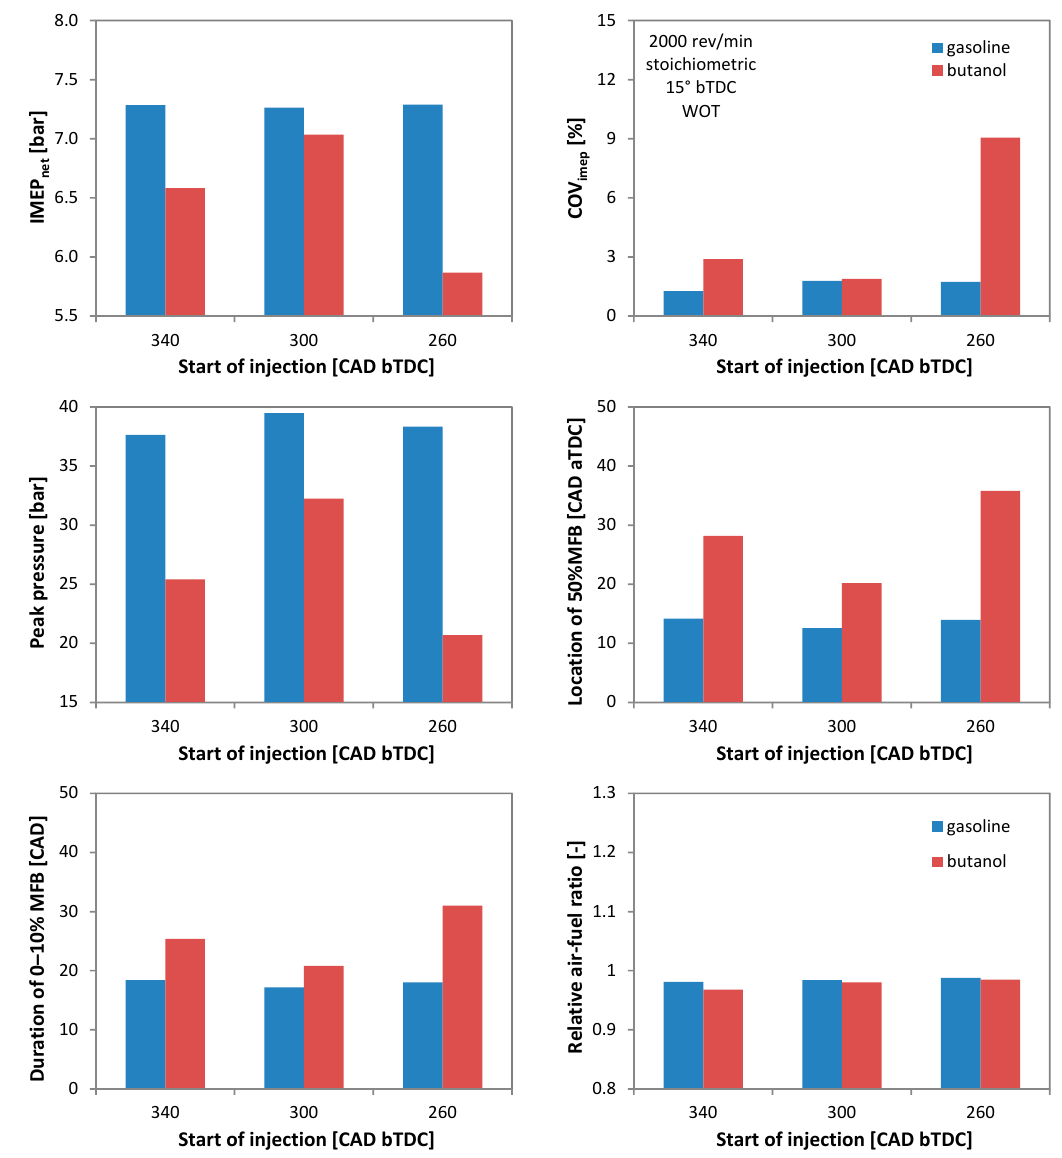
Figure 4. Overall thermodynamic and combustion phasing parameters for the two fuels.